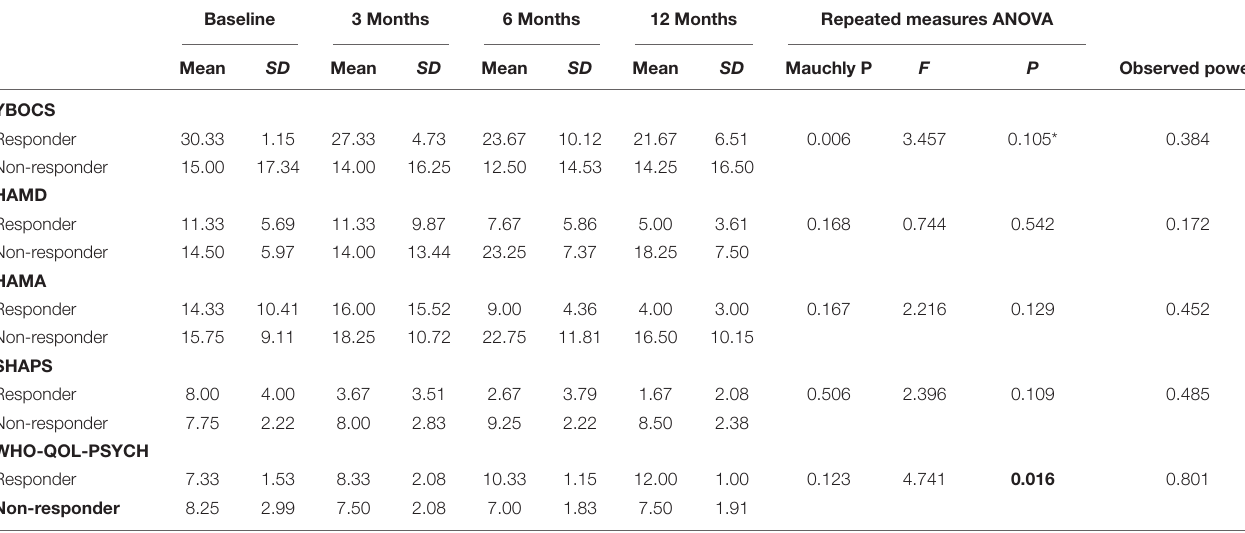
TABLE 6 | Change in psychometric scores over time.